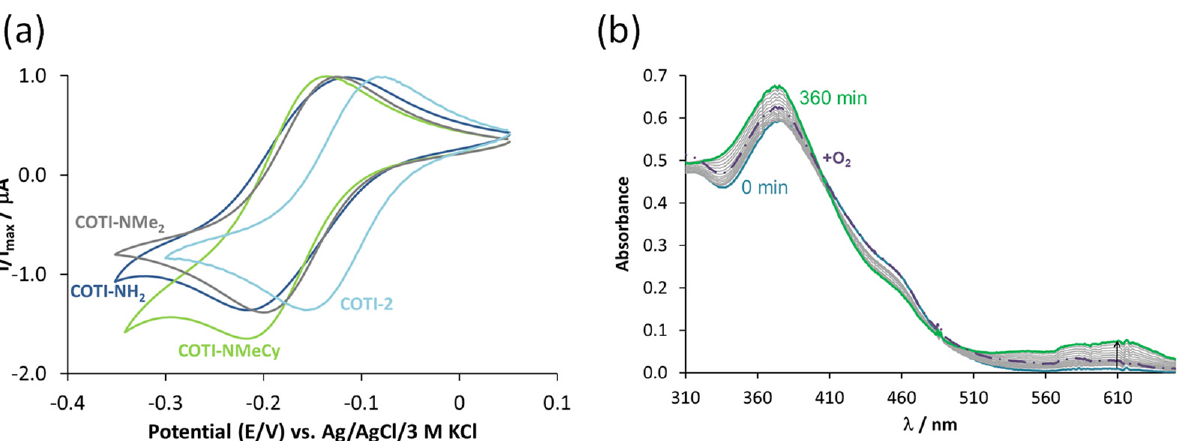
Figure 3. Cyclic voltammograms and interaction with glutathione (GSH) of iron(III)–thiosemicarbazone complexes. ( a ) Normalized cyclic voltammograms of the iron(III)–thiosemicarbazone (1:2) systems at a 0.01 V/s scan rate. c L =1 mM, c Fe = 0.5 mM, pH = 7.40 (10 mM HEPES), T = 25 °C, I = 0.1 M (TBAN), and 90% ( v/v ) DMSO/H 2 O. ( b ) Time-dependent changes in the UV-vis absorption spectra of the iron(III)–COTI-NMe 2 (1:2) system in the presence of 300 equiv. GSH (solid lines) at pH 7.4 in 5% ( v/v ) DMSO/H 2 O under argon and the spectrum of the free ligand (dashed line). c Fe(III) = 30 µM, c L = 60 µM, c GSH = 9 mM, T = 25 °C, I = 0.1 M (KCl), and ℓ = 1.0 cm.